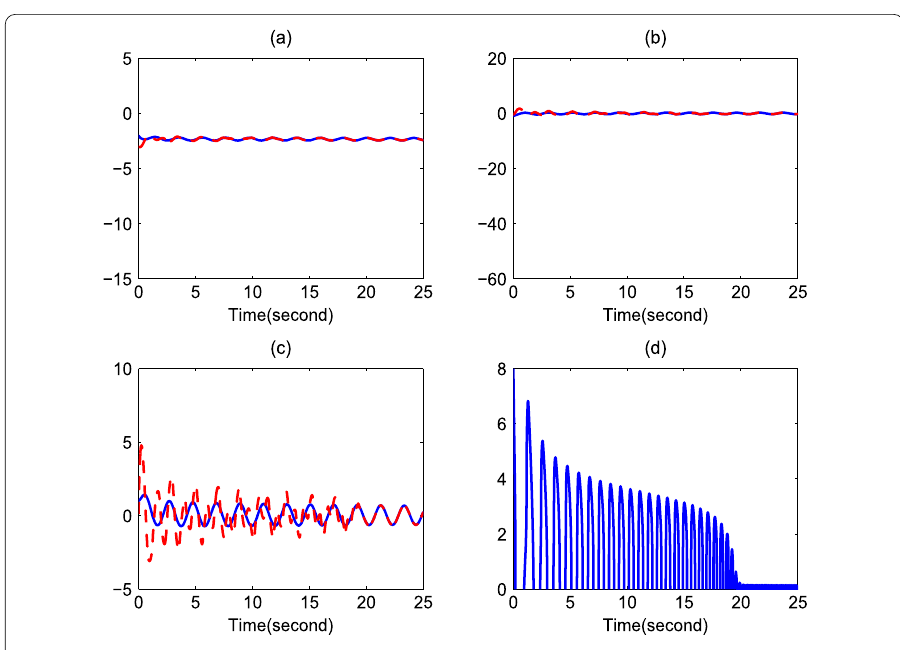
Figure 6 The state stabilization. ( a ) The 1st tracking trajectory, x 1 ( t ) (solid line) and y 1 ( t ) (dotted line). ( b ) The 2nd tracking trajectory, x 2 ( t ) (solid line) and y 2 ( t ) (dotted line). ( c ) The 3rd tracking trajectory, x 3 ( t ) (solid line) and y 3 ( t ) (dotted line). ( d ) The control input, u ( t )